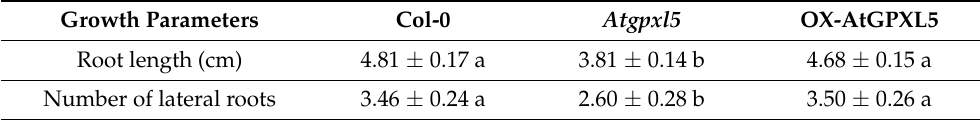
Table 1. The length of primary root and the number of lateral roots of two-week-old Arabidopsis wild type (Col-0) and glutathione peroxidase-like 5 mutant ( Atgpxl5-1 ) and overexpressing line (OX-AtGPXL5) plantlets grown in light after transferring 5-day-old seedlings onto 1 Mean ± SD, n = 15. Data were analysed using one-way ANOVA followed by Duncan’s test. Different letters represent data considered statistically significant at p ≤